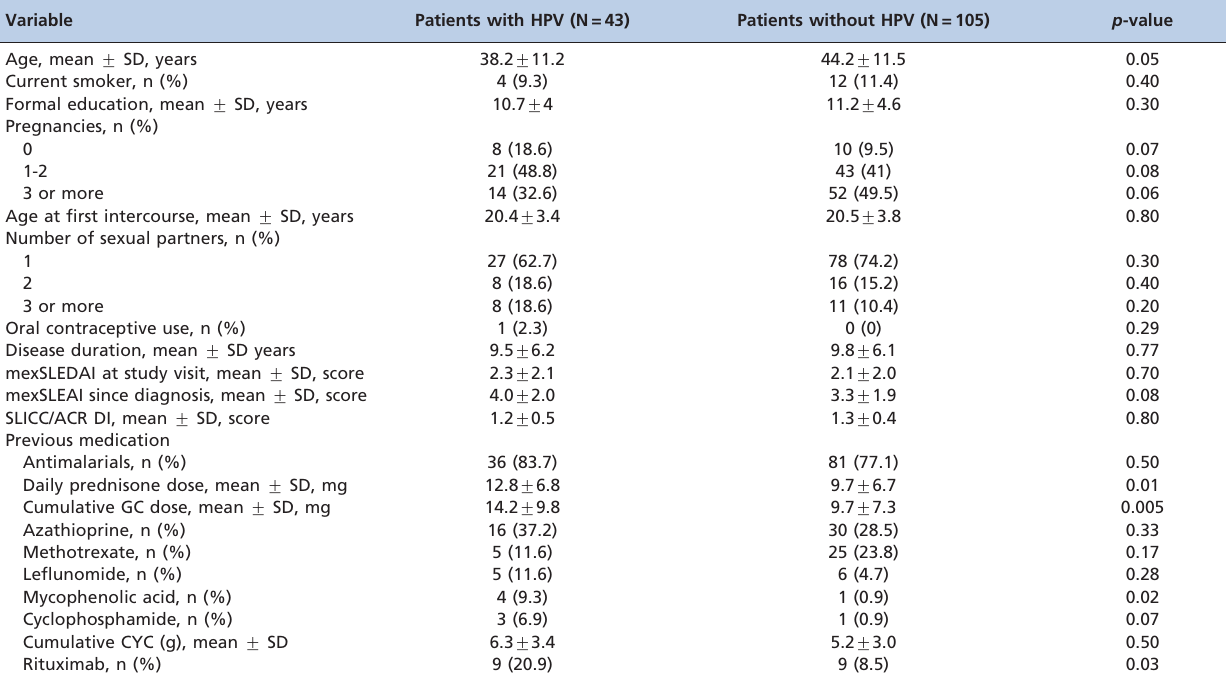
Table 2 - Sociodemographic, clinical, and treatment characteristics of patients with systemic lupus erythematosus with and without cervical HPV